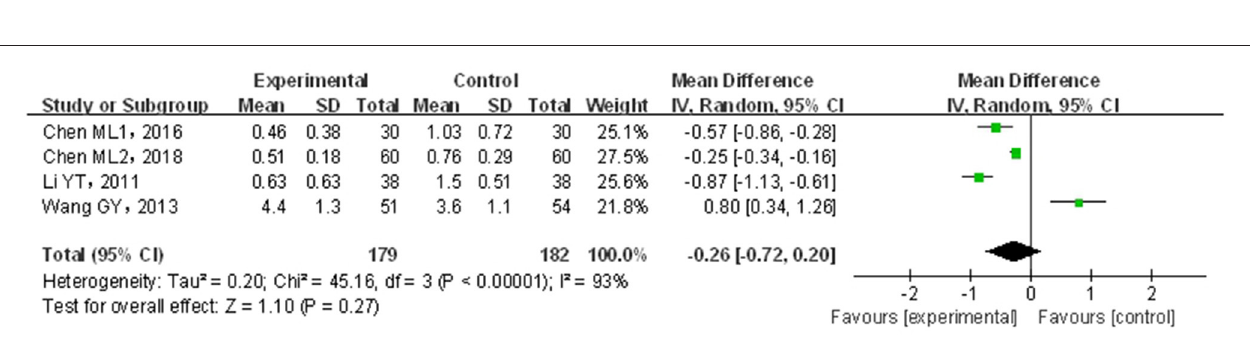
Frontiers in Public Health |